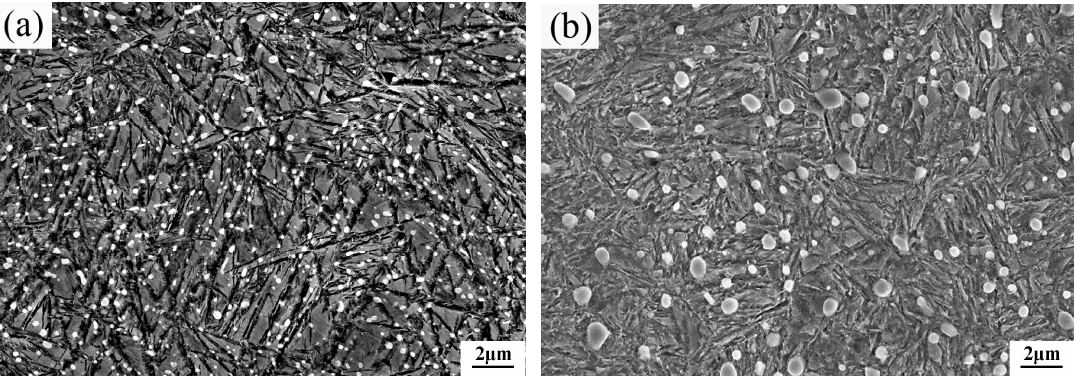
Figure 4. SEM images of the surface of the specimen after heat treatment: ( a ) CC steel and ( b ) HC steel.